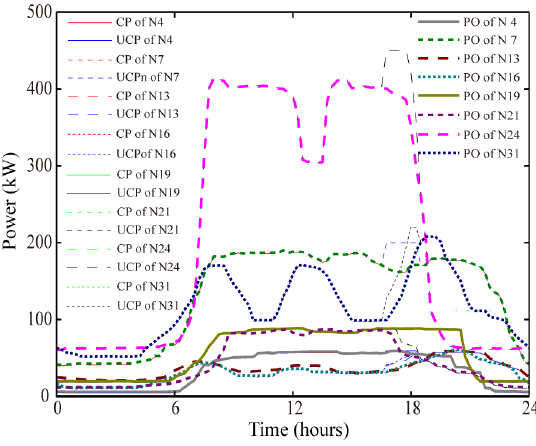
Figure 14. Power consumption profiles after control.